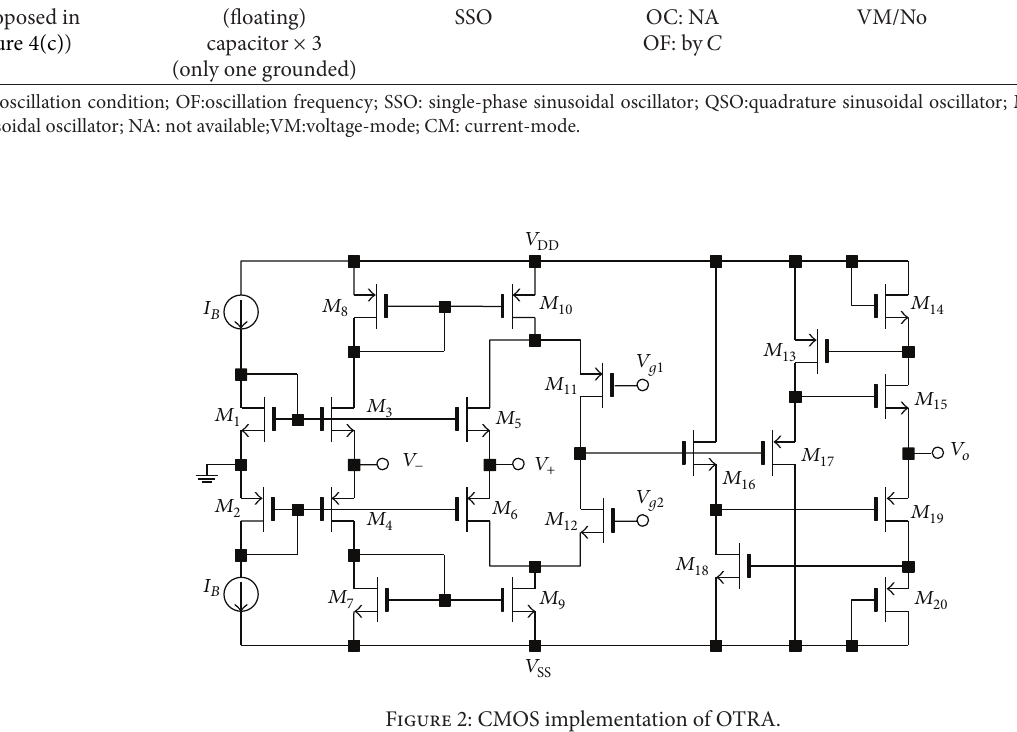
Figure 2: CMOS implementation of OTRA.